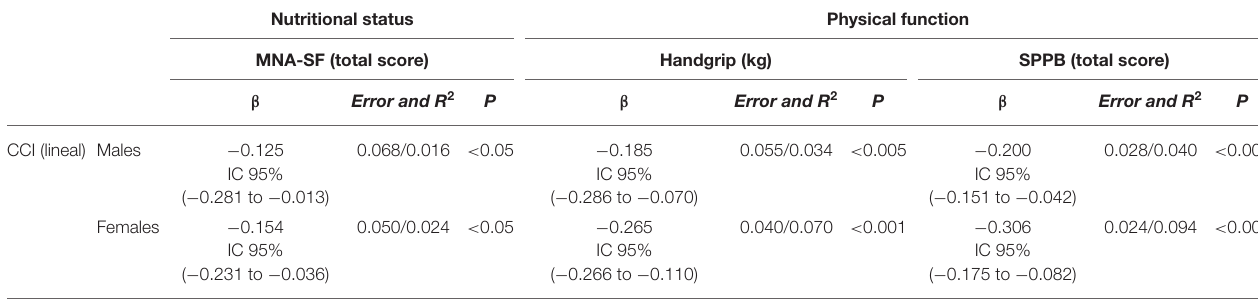
TABLE 2 | Linear regression of comorbidity risk assessed by the CCI with nutritional status and physical function by sex. Nutritional status Physical function MNA-SF (total score) Handgrip